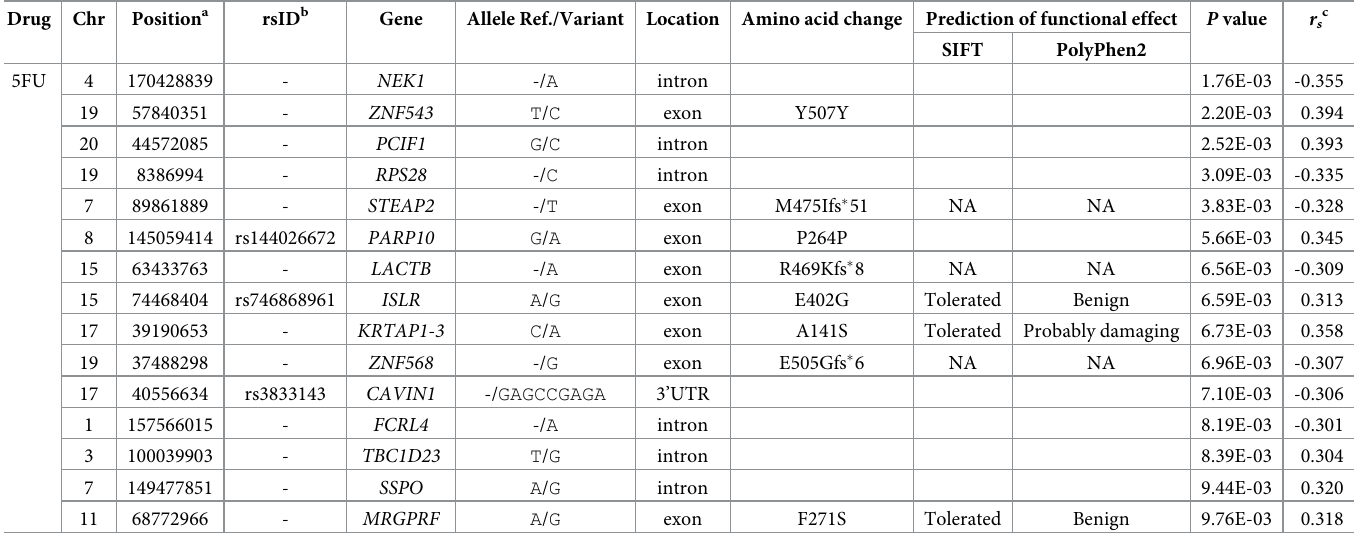
Table 1. Variants associated with chemosensitivity to 5FU (P < 0.01), as identified among 79